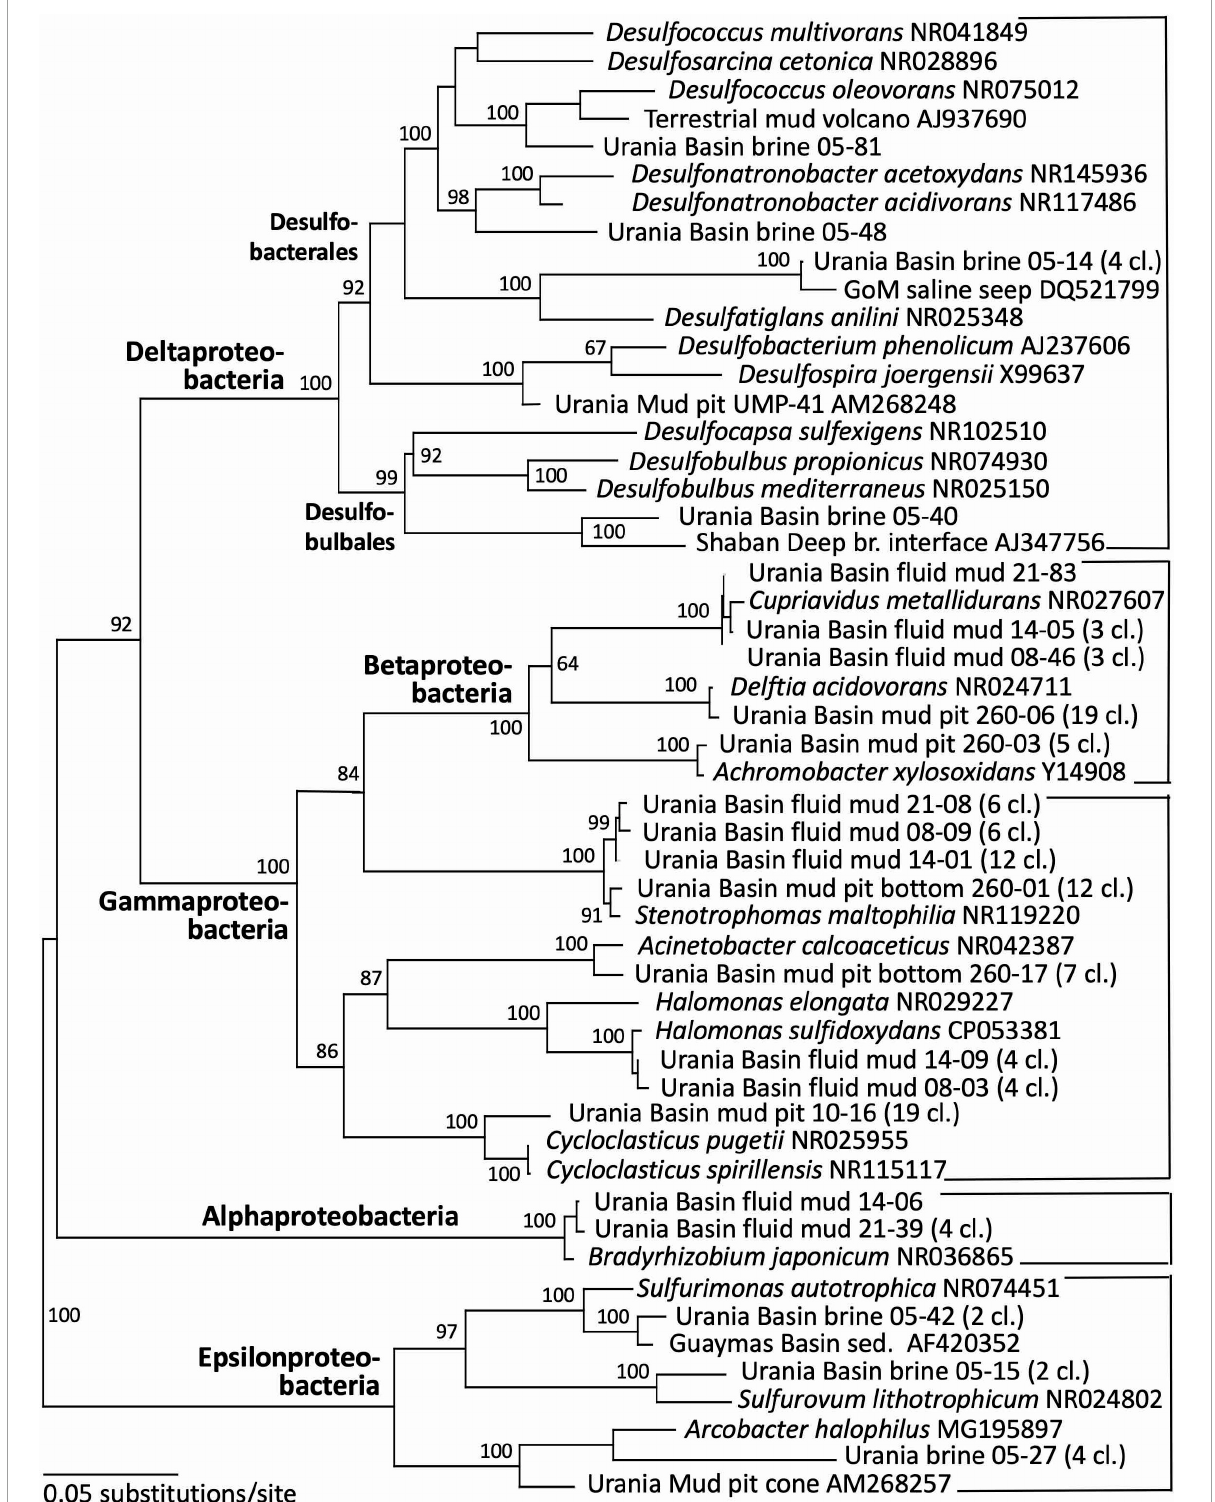
FIGURE4 Phylogeny of the Proteobacteria-affiliated 16S rRNA genes based on distance minimum evolution analysis and 1,000 neighbor-joining bootstrap iterations using PAUP (Swofford, 2000).